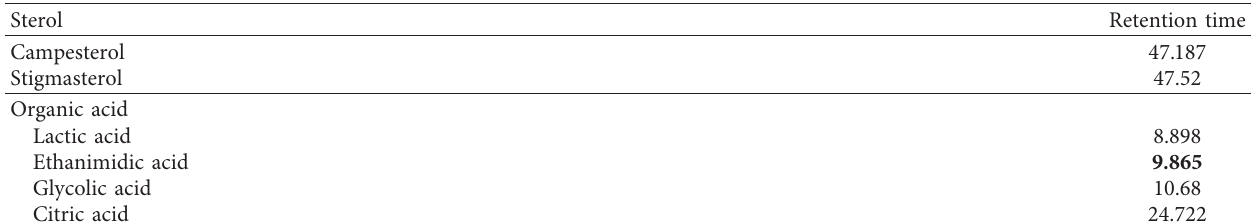
Table 4: Sterols identified in Juglans regia